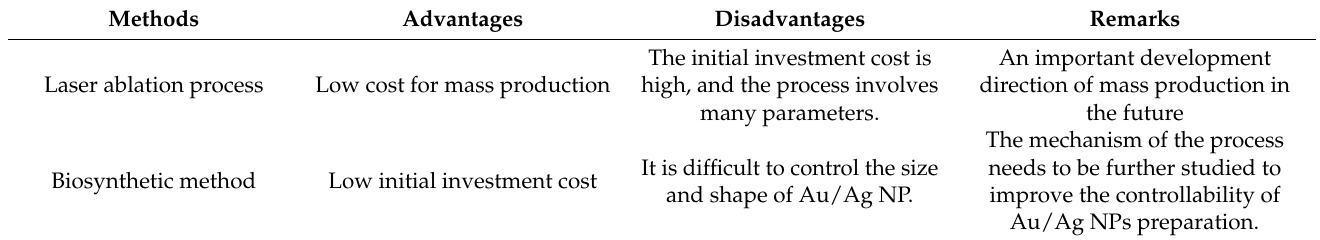
Table 4. Comparison between the laser ablation process and the biosynthetic method for the fabrica- tion Au/Ag metal